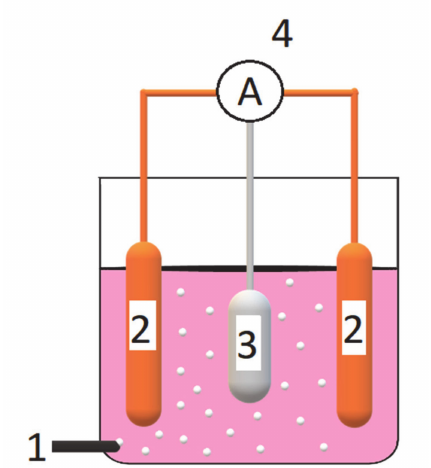
Figure 9. Schematic illustration of galvanic cell-based wastewater electrolysis system, where: 1—is an aeration system (oxygen was delivered from compressed 200 bar cylinder); 2—are copper cathodes; 3—is an Al alloy sacrificial anode; and 4—is an ammeter and electrical